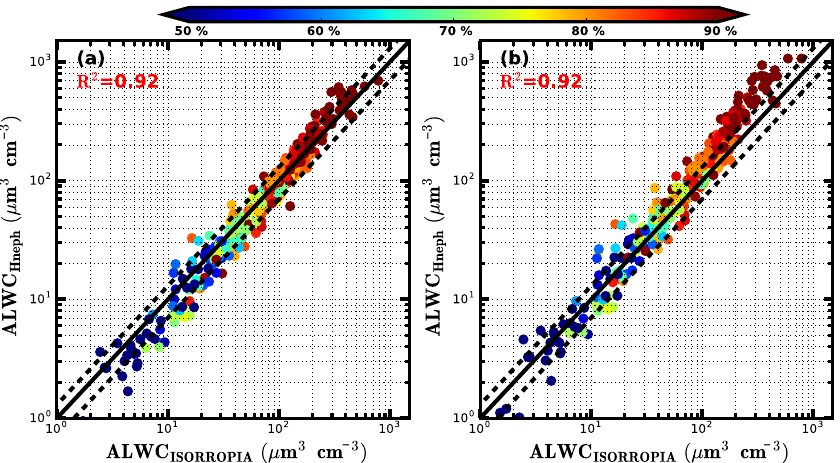
Figure 10. The comparison between ALWC calculated from ISORROPIA thermodynamic model (ALWC ISORROPIA ) and ALWC calculated from measurements of the humidified nephelometer system (ALWC Hneph ). The black solid line is the 1:1 line and the two dashed black lines are 30% relative difference lines. R 2 is the square of correlation coefficient. Colours of scatter points represent ambient RH. (a) ALWC Hneph is calculated using the method proposed in this research. (b) ALWC Hneph is calculated by assuming Vg(RH) = f (RH) 1 . 5 (Guo et al.,